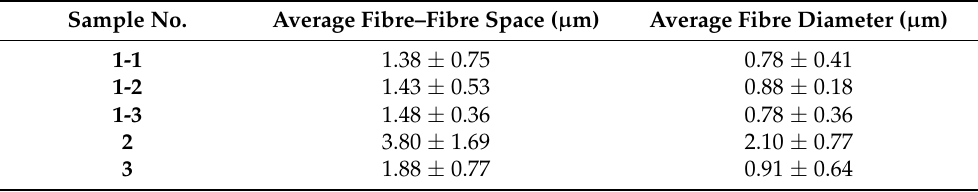
Table 4. Average fibre-fibre space and fibre diameter of electrospun scaffolds. Sample No.